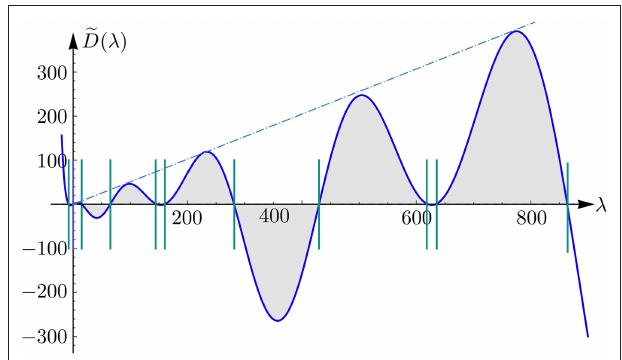
FIGURE 4 | Plot of the approximate function